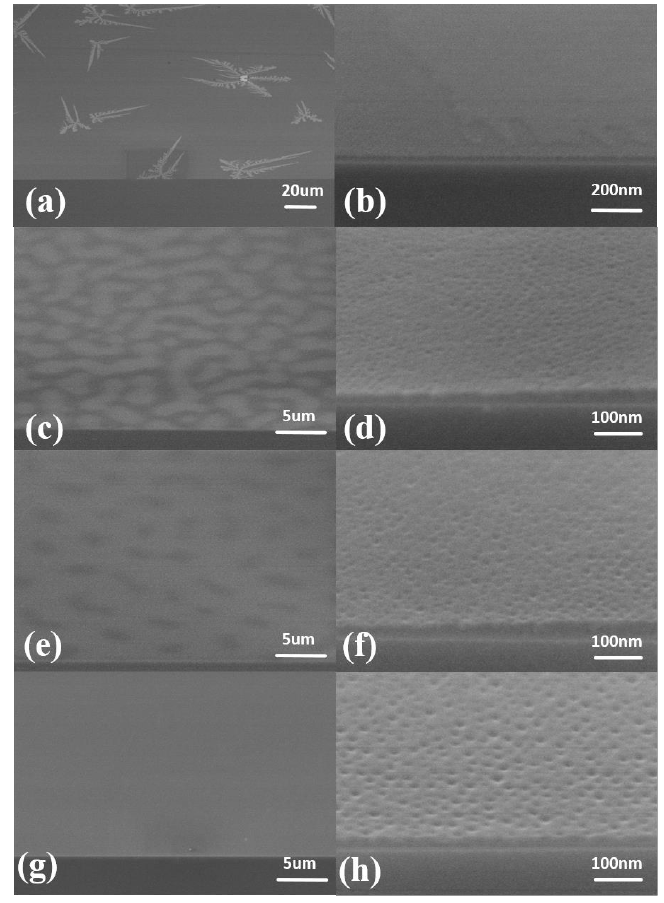
Figure 1. SEM images of air atmosphere annealing. The thickness of blend materials is about 20 nm. The annealing temperature is 130 °C, and the annealing time is different: ( a , b ) 10 min; ( c , d ) 20 min; ( e , f ) 30 min; ( g , h ) 40 min.